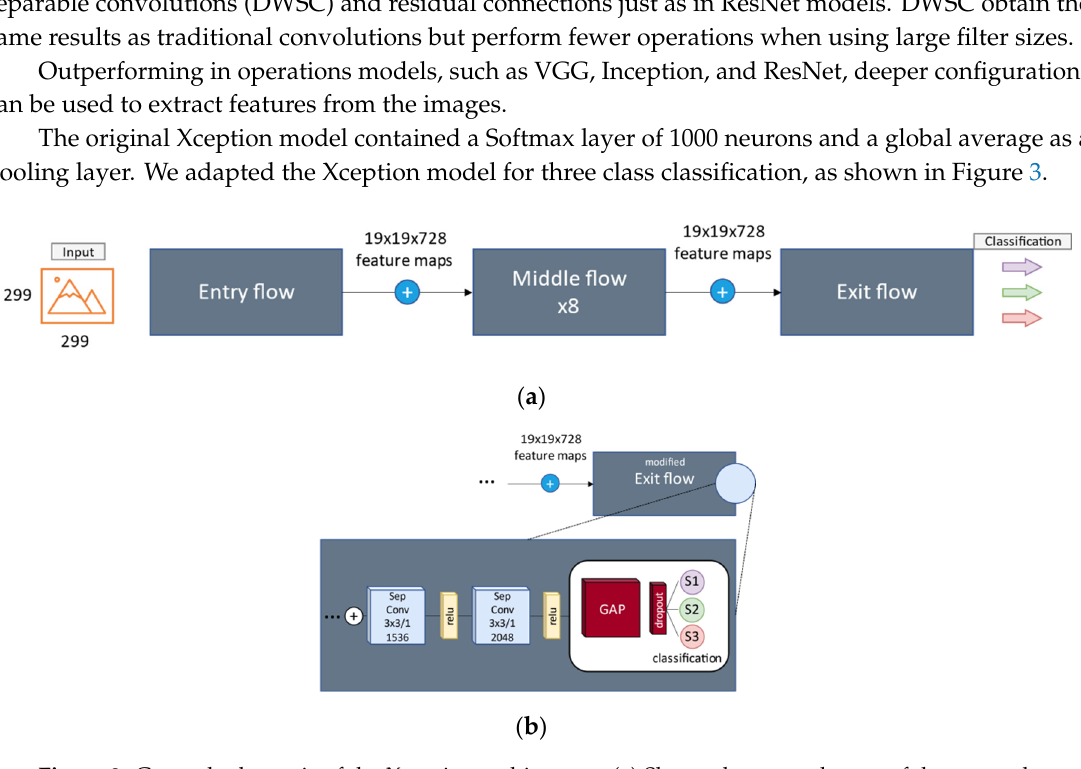
Figure 3. General schematic of the Xception architecture. ( a ) Shows the general parts of the network; ( b ) shows the modified segment of the network in this research.